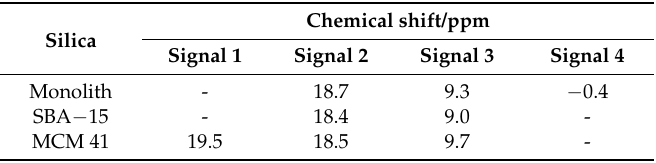
Figure 4. 31 P CP-MAS-NMR spectra of MCM-41, SBA-15, and a monolith functionalized with phenylphosphonic acid (PPA, 1 ). The spectra were measured at a spinning frequency of 8 kHz and exhibit spinning sidebands near 80 and − 60 ppm. Table 4. 31 P CP magic-angle spinning (MAS) NMR shifts of monolith, SBA-15, and MCM-41, functionalized with phenylphosphonic acid (PPA, 1